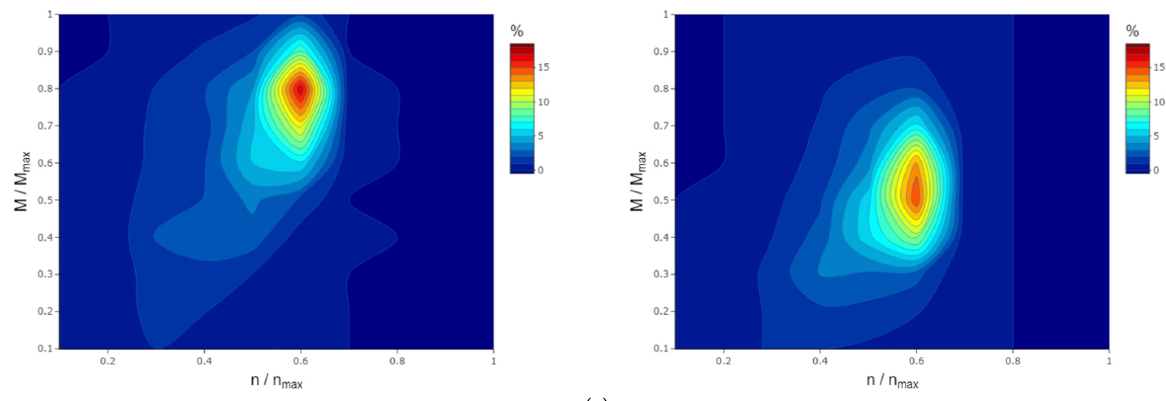
Figure 4. Frequency distribution maps (i.e., timeshare, shown in percent) of the engine operating points recorded during driving on various roads for Vehicle 1 (on the right side) and Vehicle 2 (on the left side) ( a ) city roads, ( b ) rural roads, ( c ) motorways.